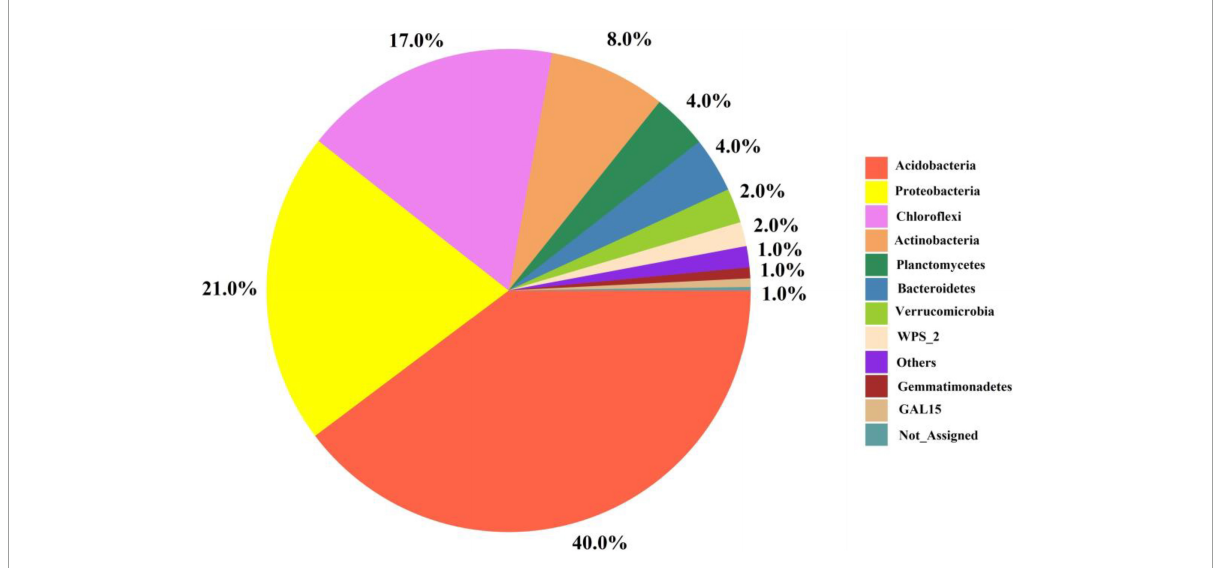
FIGURE4 The interactive pie chart exploration of bacteria at phylum level among all soil